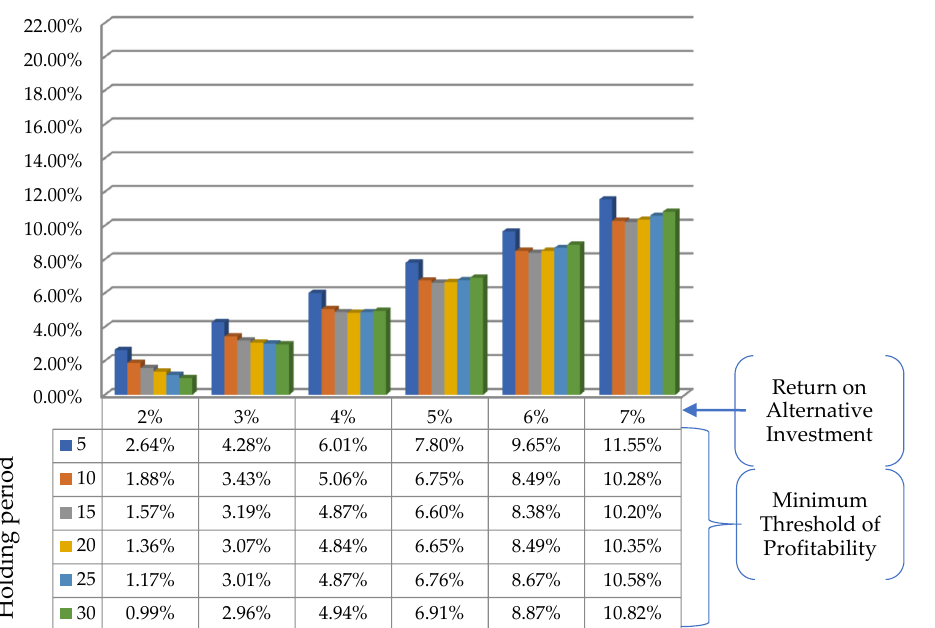
Figure 3. Distribution of the minimum threshold of profitability ( Pmt ), depending on the holding period and return on alternative investment.